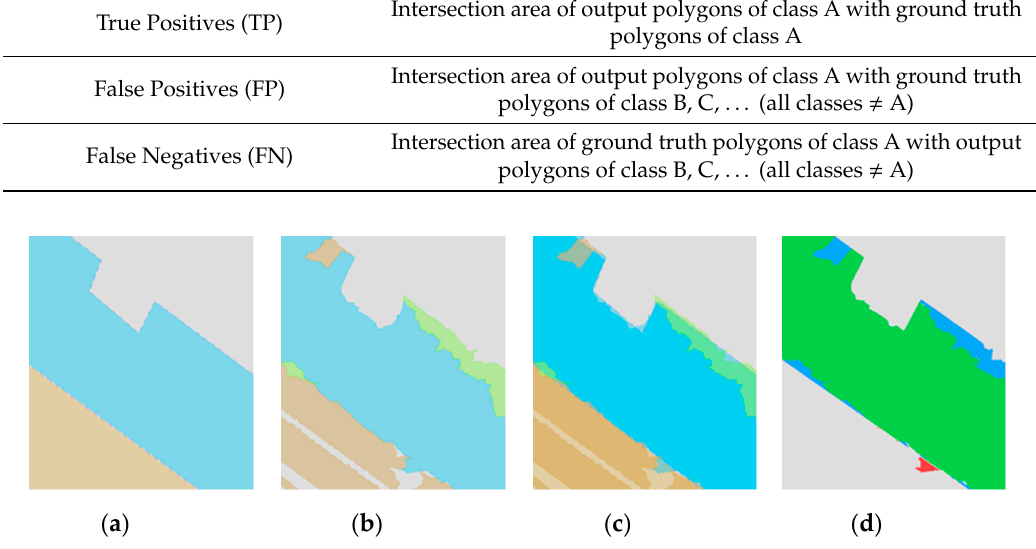
Figure 7. Computation of true and false positive areas for pavement (light blue): (a) Reference; (b) Figure 9. Computation of true and false positive areas for pavement (light blue): ( a ) Reference; output; (c) overlay; (d) true positive (TP) (green), false positive (FP) (red), and false negative (FN) ( b ) output; ( c ) overlay; ( d ) true positive (TP) (green), false positive (FP) (red), and false negative (blue). (FN)